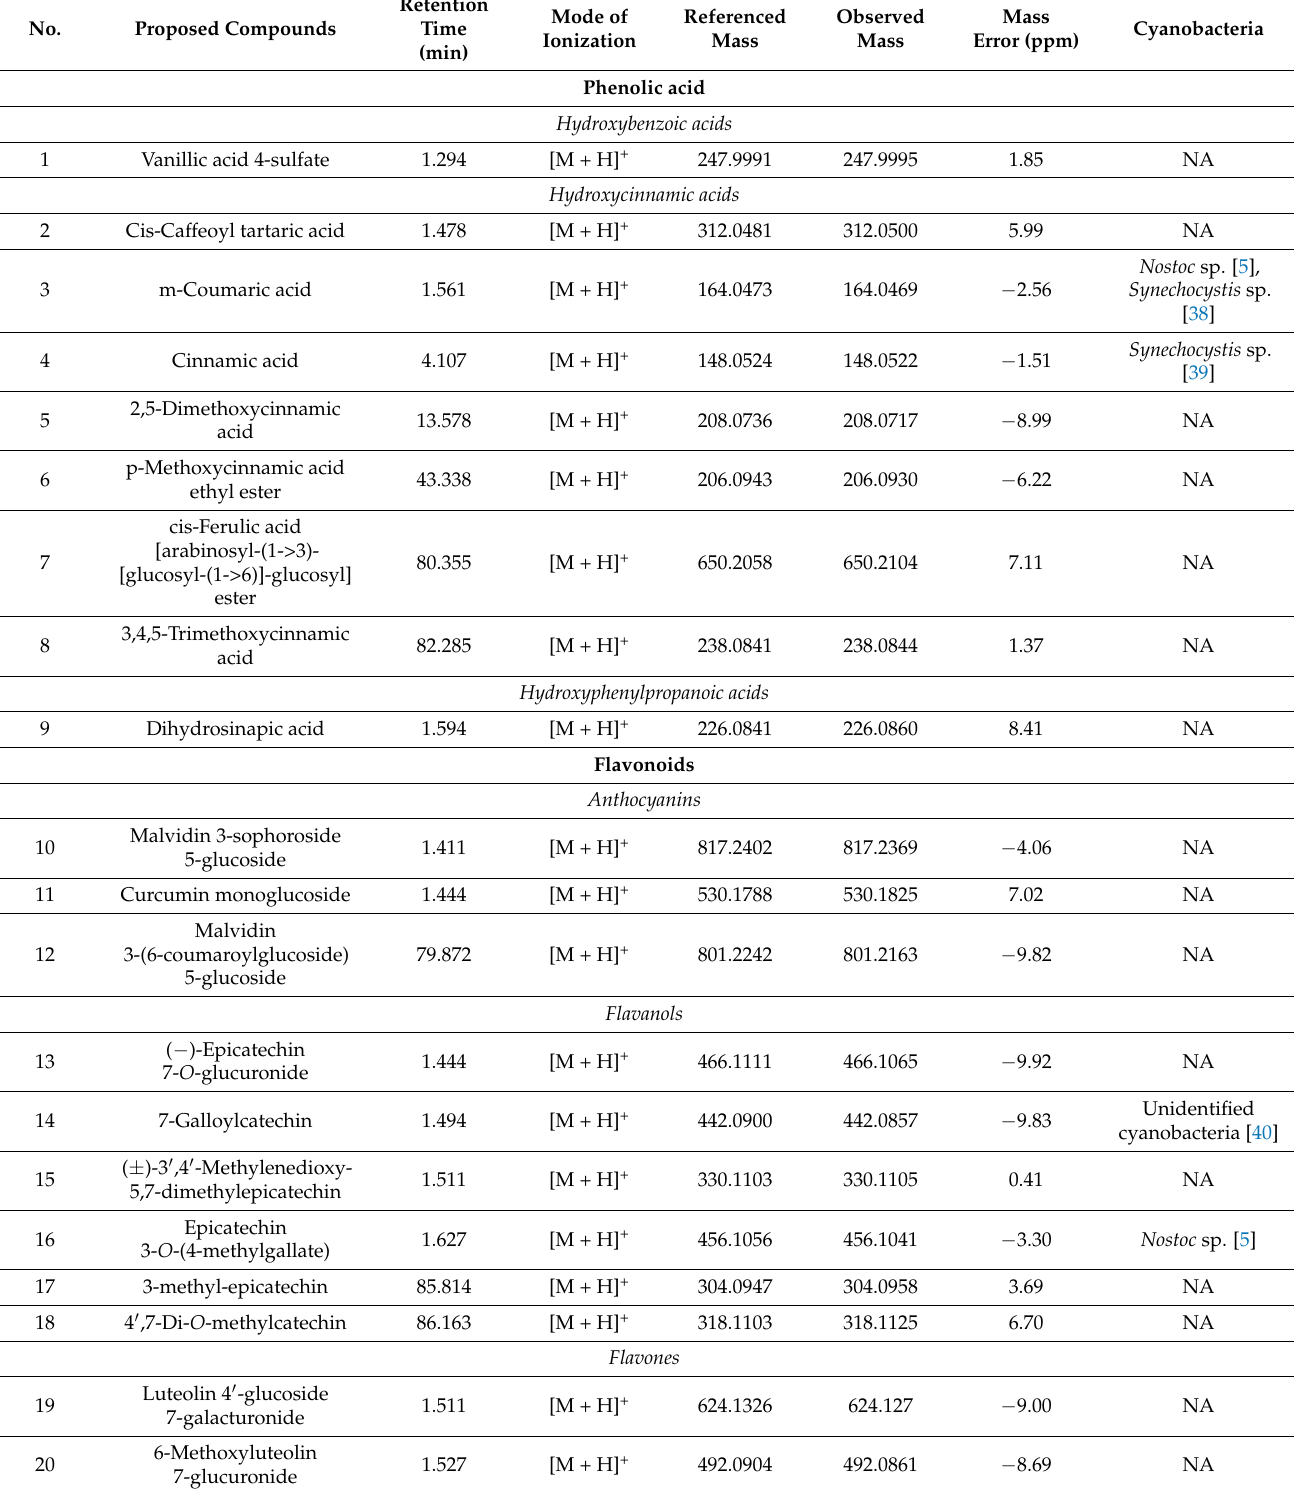
Table 2. Liquid chromatography–electrospray ionization–quadrupole time-of-flight–mass spectrome- try (LC–ESI–QTOF–MS/MS) polyphenol profiling in the ethanolic extract of Leptolyngbya sp.